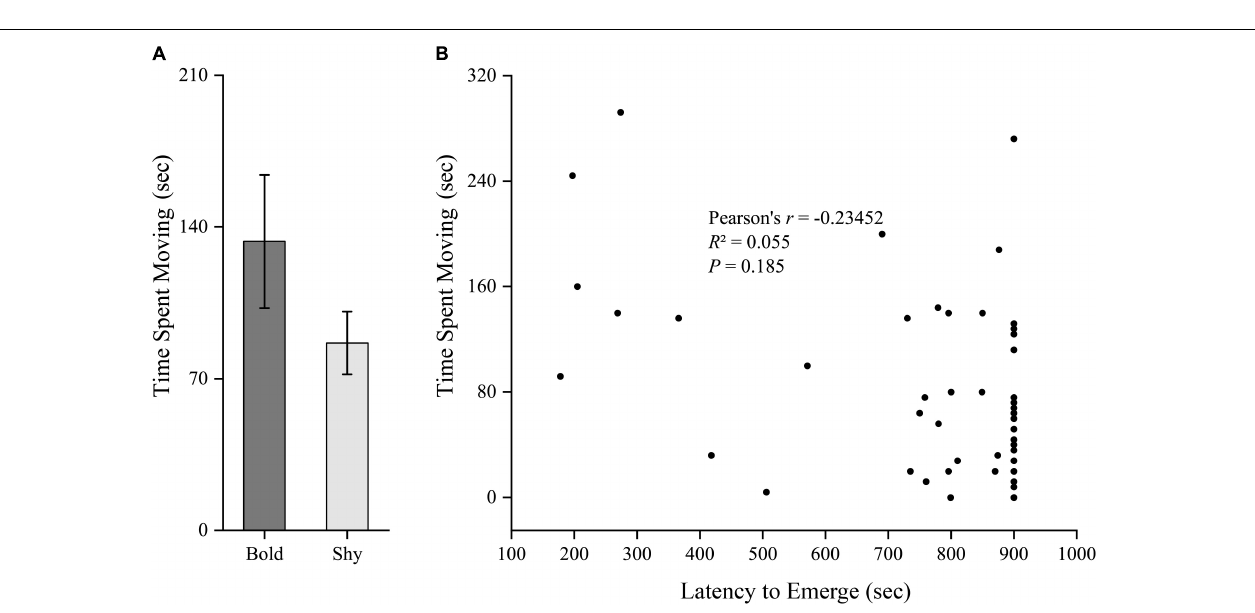
FIGURE 2 | The boldness and aggressiveness of black rockfish. (A) The number of aggressive behavior in bold ( n = 9) and shy ( n = 44) groups. Different letters indicate significant differences ( P < 0.05; independent samples t -test). (B) Linear fit of the latency to emerge from the start box (box-emerging boldness test) and the number of aggressive behavior ( n = 53).